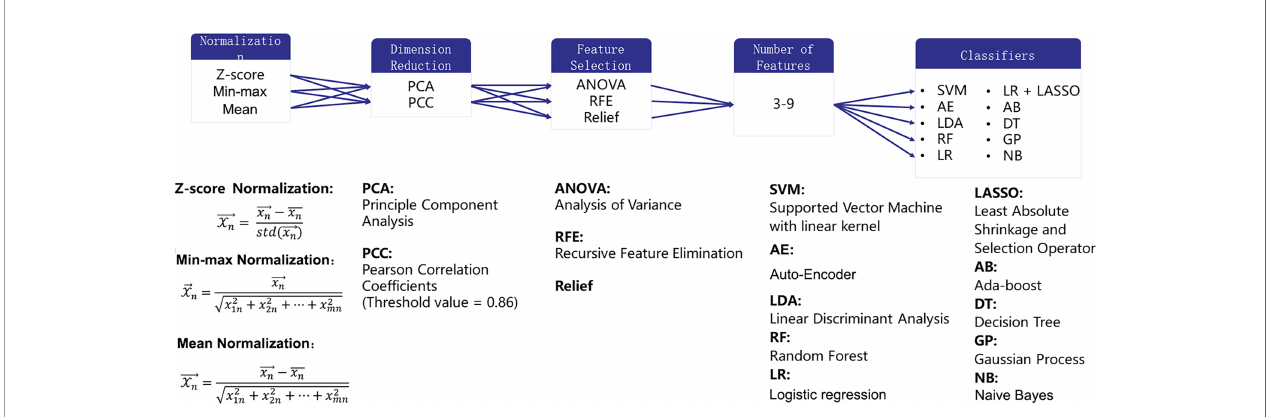
FIGURE 3 | Combination of the pipelines for